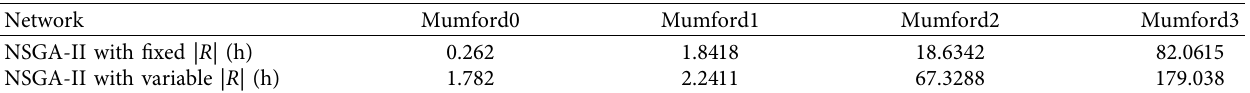
Table 7: Computation time of optimization procedure for Mumford’s